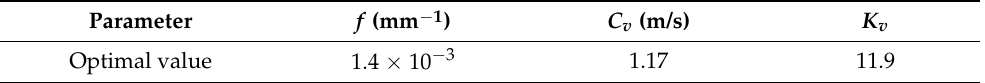
Figure 5. NSE objective function results for the five flood events considered in the calibration process. Columns show flood events. Rows show the three parameters used to calibrate the model: f , K v , C v . Red circles represent the best combination of parameter values identified in the calibration process. Table 7. RIBS parameter values for the best combination identified in the calibration process.